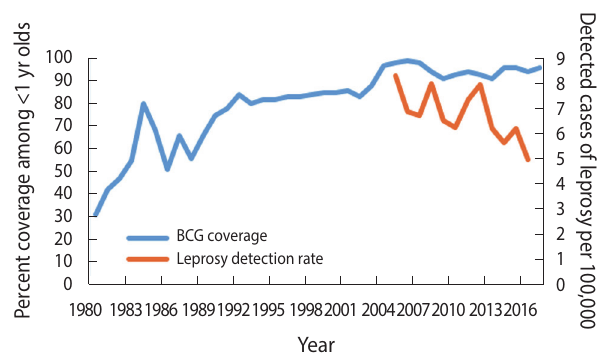
Figure 1. Bacillus of Calmette and Guérin (BCG) vaccination cover- age estimates and reported leprosy detection rates, Paraguay,